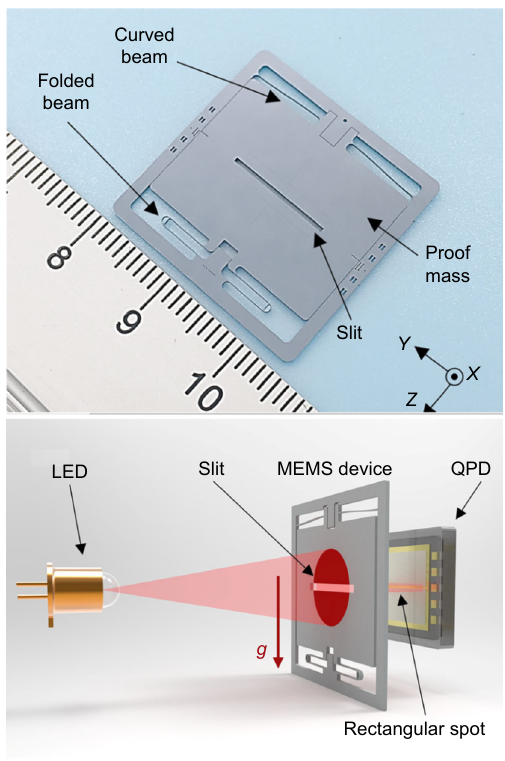
Fig. 7 | Schematic of the MOEMS accelerometer. Figure repro- duced with permission from ref. 24 , Springer